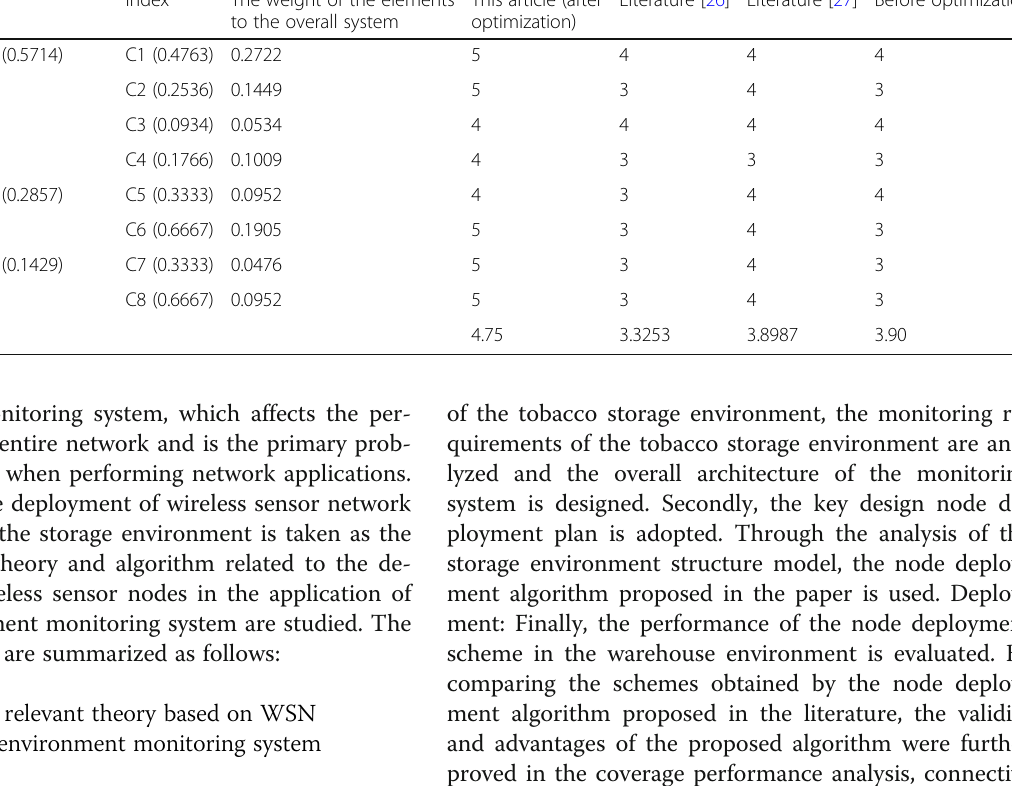
Table 4 The actual rating scale and comprehensive weights Level 1 indicator Level 2 indicator Level 3